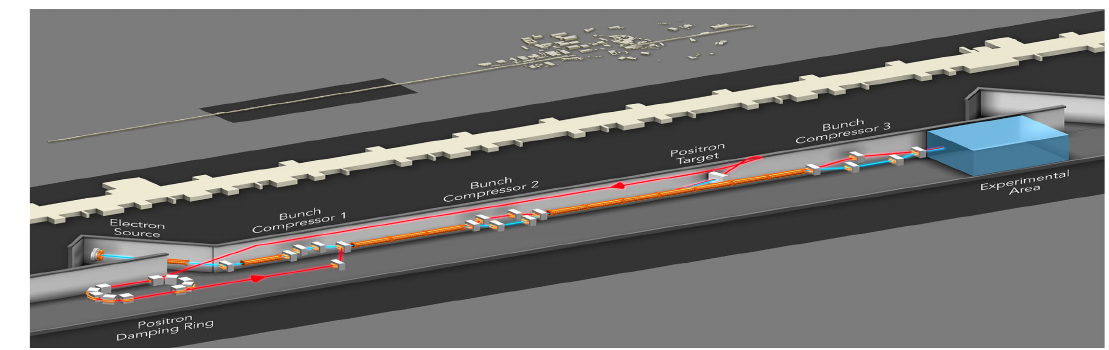
FIG. 1. Schematic layout of FACET-II in the middle third of the SLAC linac, downstream of LCLS-II, and upstream of